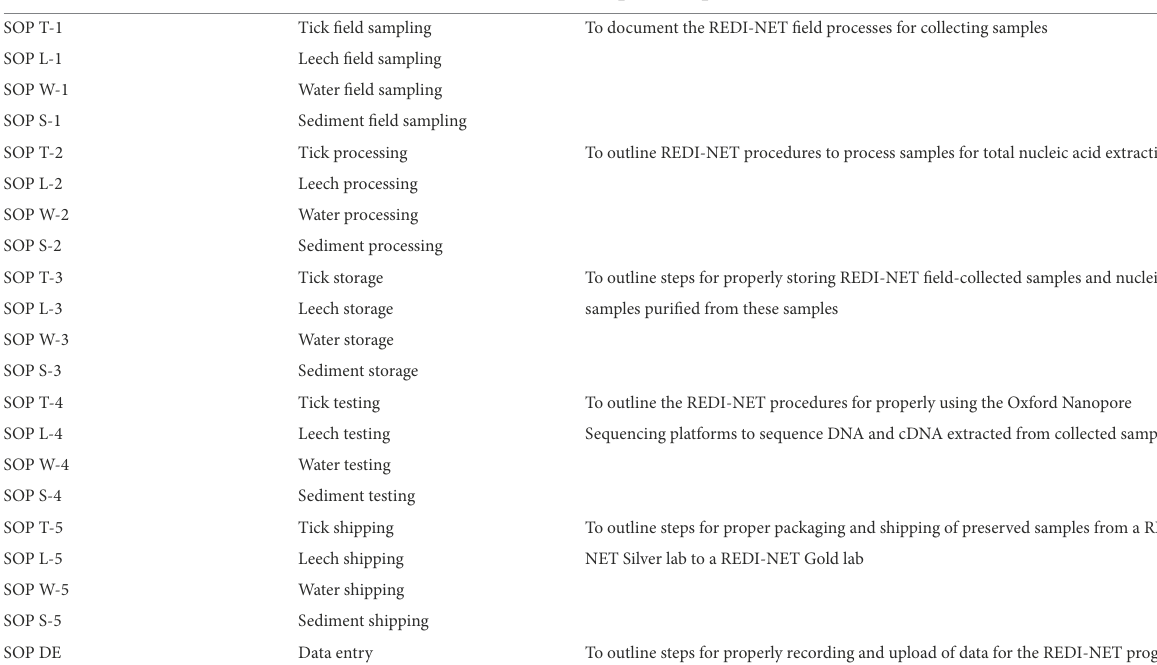
TABLE 2 Phase I REDI-NET standardized operating procedure (SOP) list.